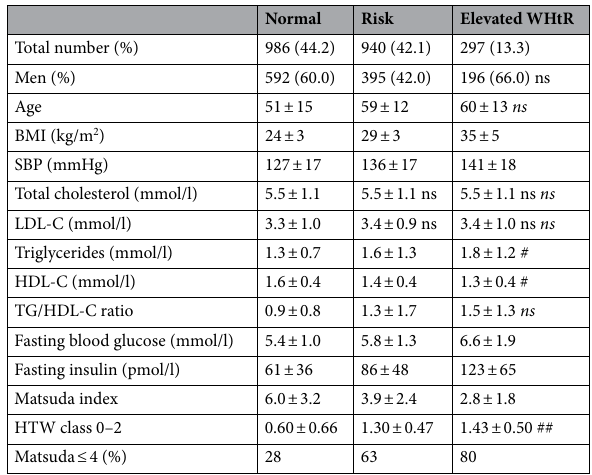
Table 2. Subgroups of waist-to-height ratio: differences between the groups are p < 0.001 unless indicated otherwise. Data are given as mean ± standard deviation. In comparison to normal ns = no significance, * p < .05 and ** p < 0.01. In comparison to risk ns = no significance, #p < 0.05 and ##p < 0.01. Normal, risk and elevated WHtR are defined in the method section. SBP systolic blood pressure, HTW classes as normal, risk and elevated are defined in the method section.